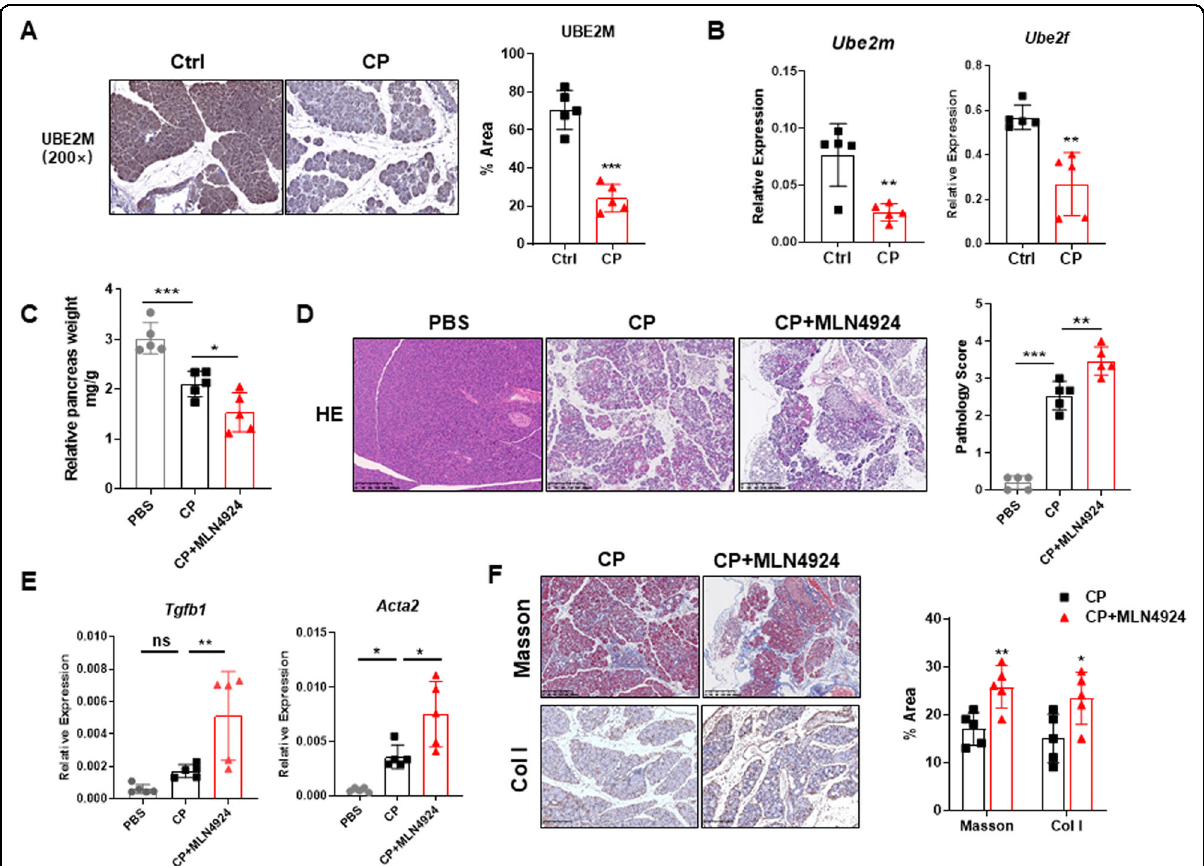
Fig. 1 Neddylation inactivation exacerbates chronic pancreatitis. A Representative IHC images of UBE2M in normal and CP pancreata. B mRNA expression of Ube2m and Ube2f . C Relative pancreas weight (pancreas weight/body weight). D Representative H&E images and pathological scores. Scale bar, 200 μ m. E mRNA expression of Tgf β and Acta2 ( α SMA). F Representative Masson images, IHC images of collagen I, and bar graphs. Scale bar, 200 μ m. A – F n = 5. Data are representative of three independent experiments. *p < 0.05, ** p < 0.01, *** p < 0.001, ns no signi fi